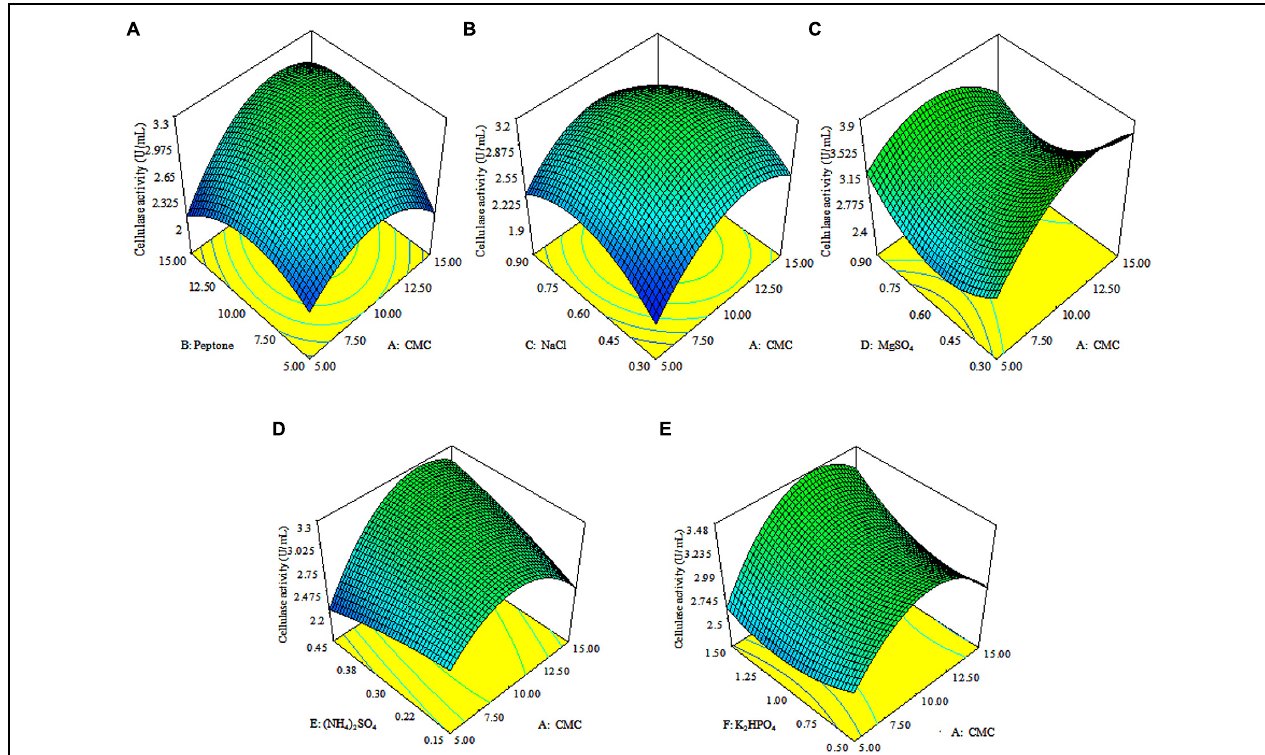
FIGURE 3 | Response surface plots. The 3D plots showing individual and interactive effects of variables on CMCase activity of Enhydrobacter sp. ACCA2, effect of CMC and peptone (A) , effect of CMC and NaCl (B) , effect of CMC and MgSO 4 (C) , effect of CMC and (NH 4 ) 2 SO 4 (D) , effect of CMC and K 2 HPO 4 (E) .